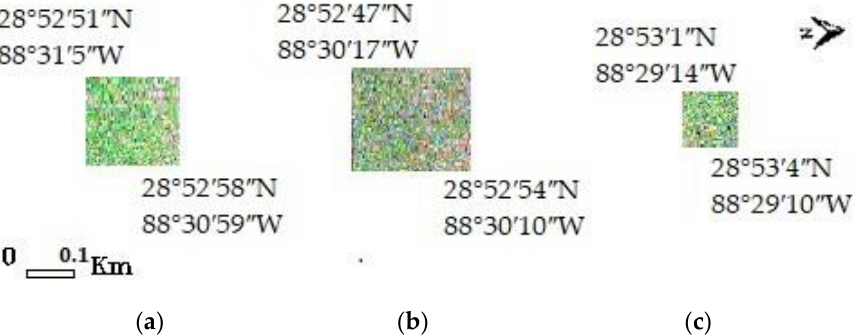
Figure 5. False color RGB images (R: 1662 nm, G: 1363 nm, B: 1005 nm) of the oil spill in the Gulf of Mexico recorded by AVI RIS on 9 July 2010. ( a – c ) are marked with coordinates of upper left and lower right corners. Table 1. Main parameters of images in Figures 4 and 5.